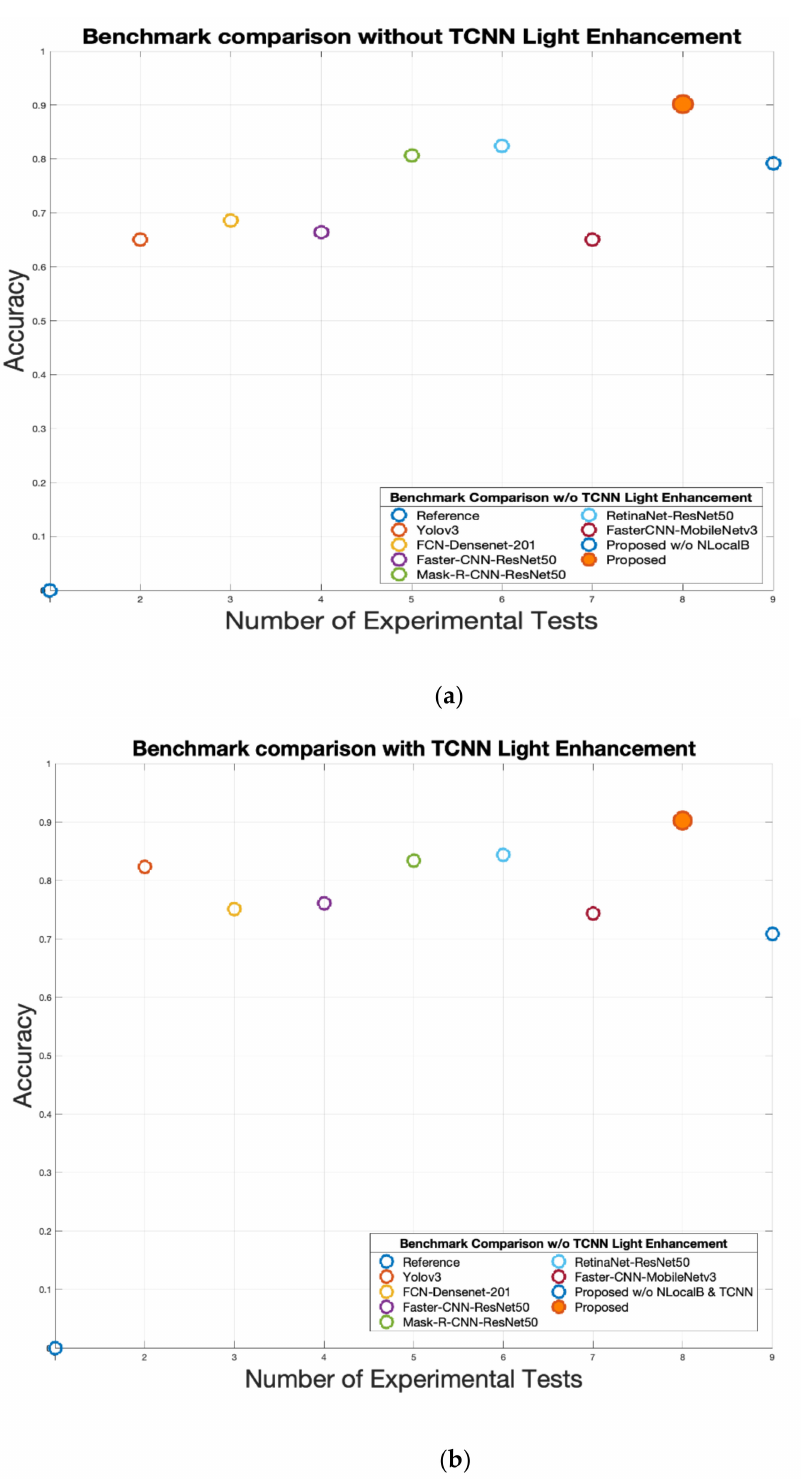
Figure 5. ( a ) Benchmark comparison in terms of accuracy without TCNN low-light enhancement pre-processing; ( b ) benchmark comparison in terms of accuracy with the proposed TCNN low-light enhancement